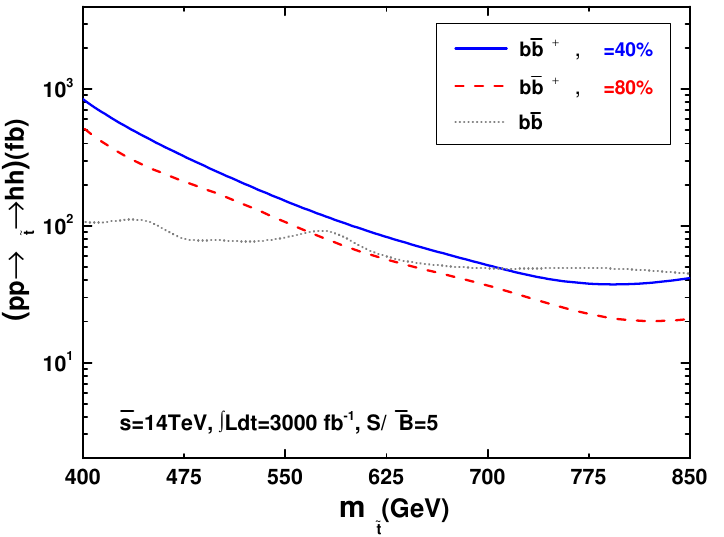
= 500 GeV and (cid:27) ( gg ! (cid:17) ~ ! hh ) = 1 pb. t ~ t